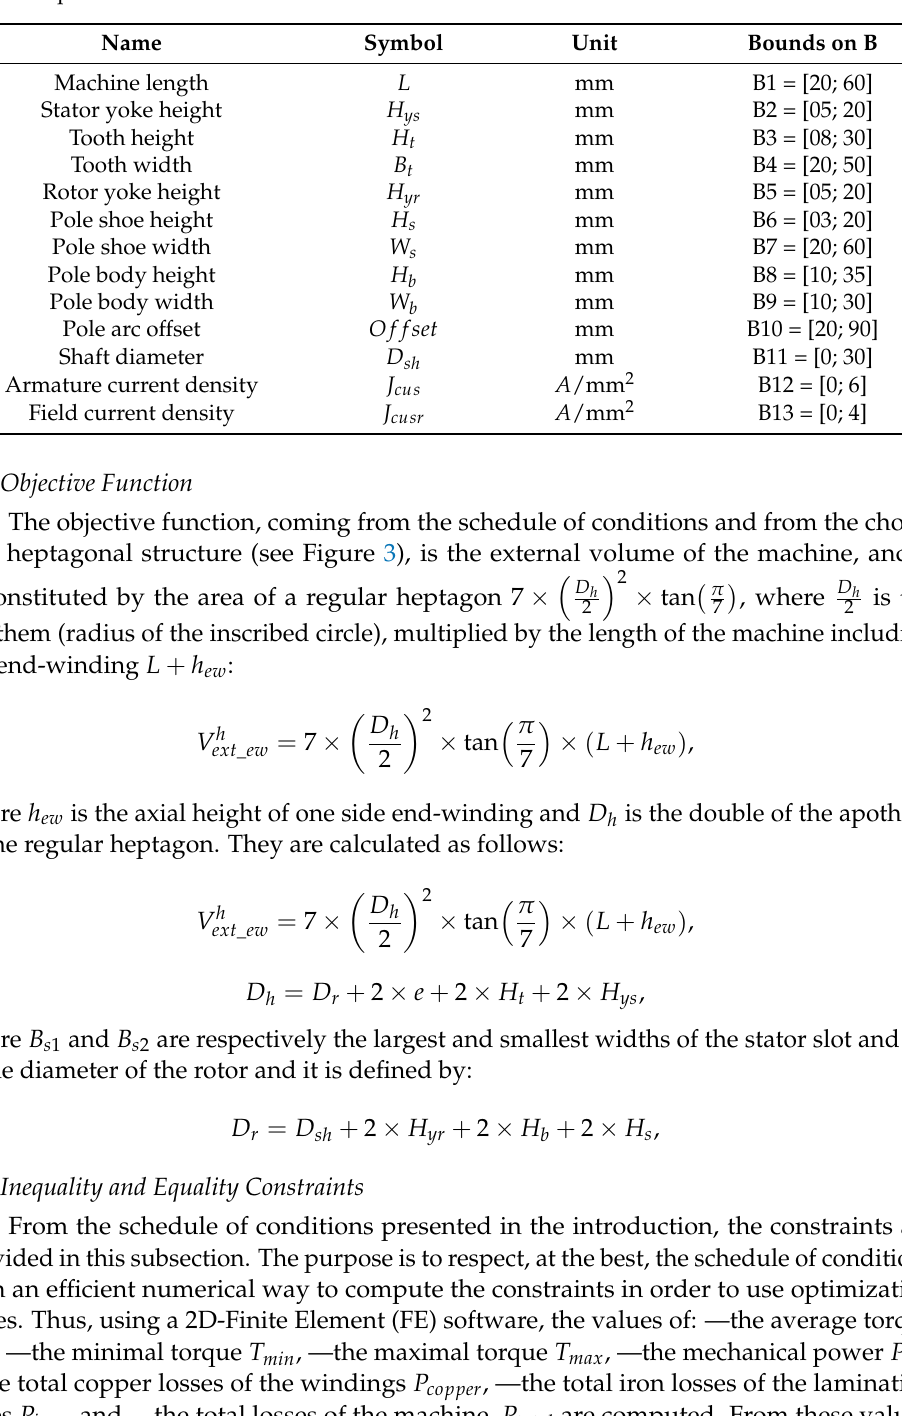
Table 1. Optimization